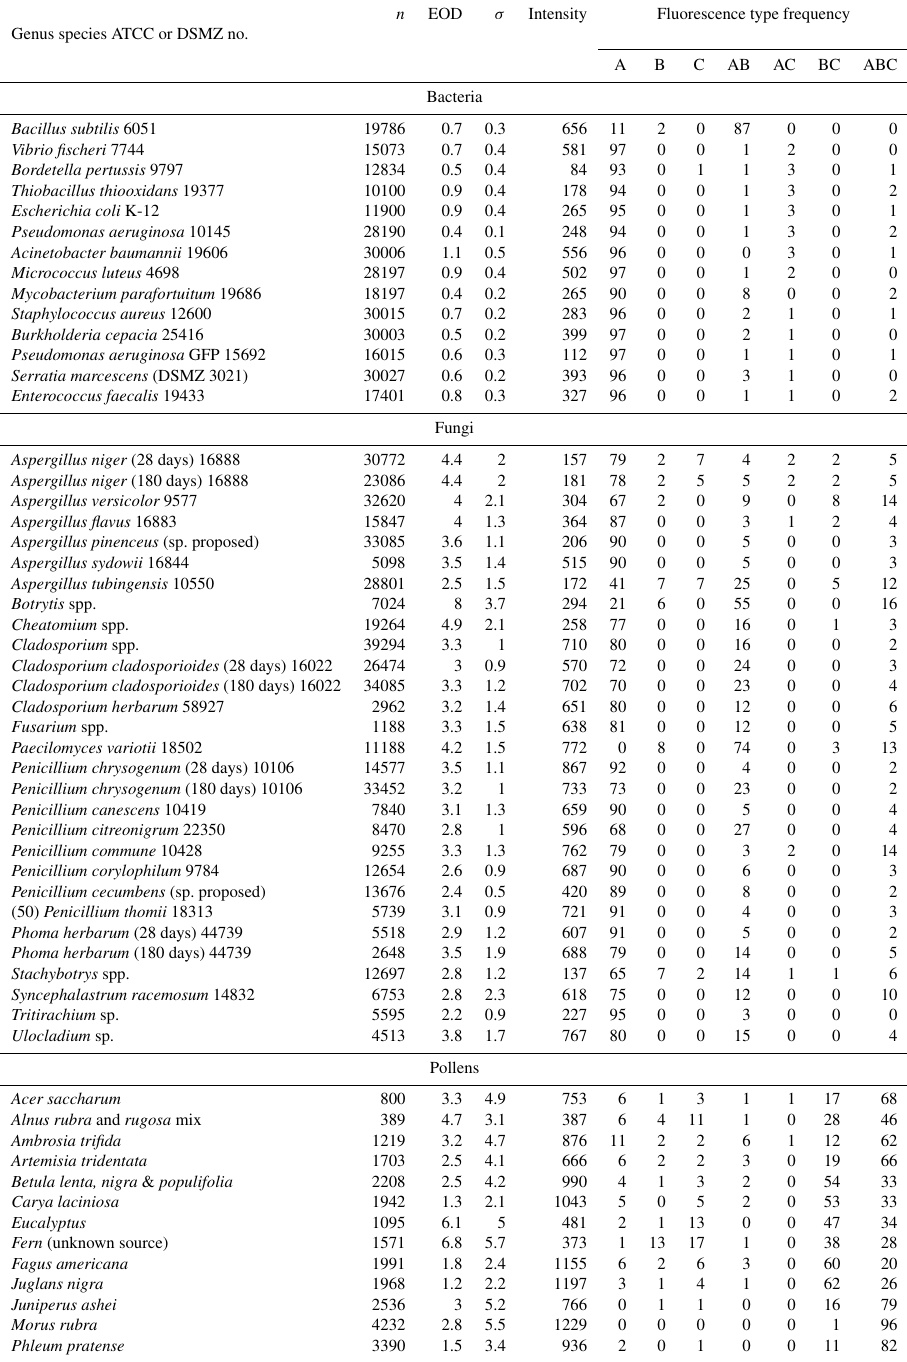
Table A1. Summary of properties observed for airborne bacteria, fungi and